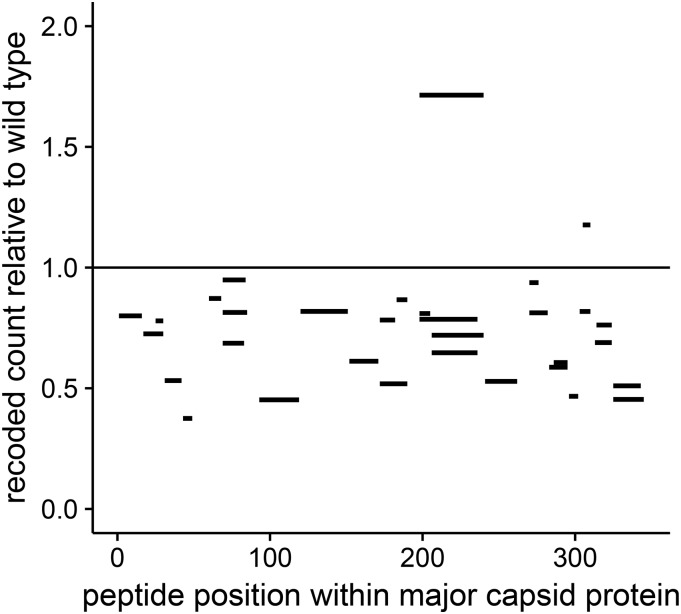
Peptide abundances are uniformly distributed across the capsid protein in the recoded T7 strain. Shown are the abundances of individual peptides within the capsid protein of the recoded strain, relative to the wild type. Data are from 9 min after infection. If translation consistently terminated before the stop codon in recoded gene 10, we would expect the relative peptide abundance to systematically vary with the location of the peptide. Therefore, we tested a model that includes an interaction between strain and peptide location, and a model that includes no interaction (see Materials and Methods). We found that a model in which an interaction is included between the strain and peptide location fits the peptide count data no better than a model without interaction (log-likelihood=−1682.2,
log-likelihood=−1682.4, respectively). Thus, in the recoded strain, there is no evidence of early translation termination.